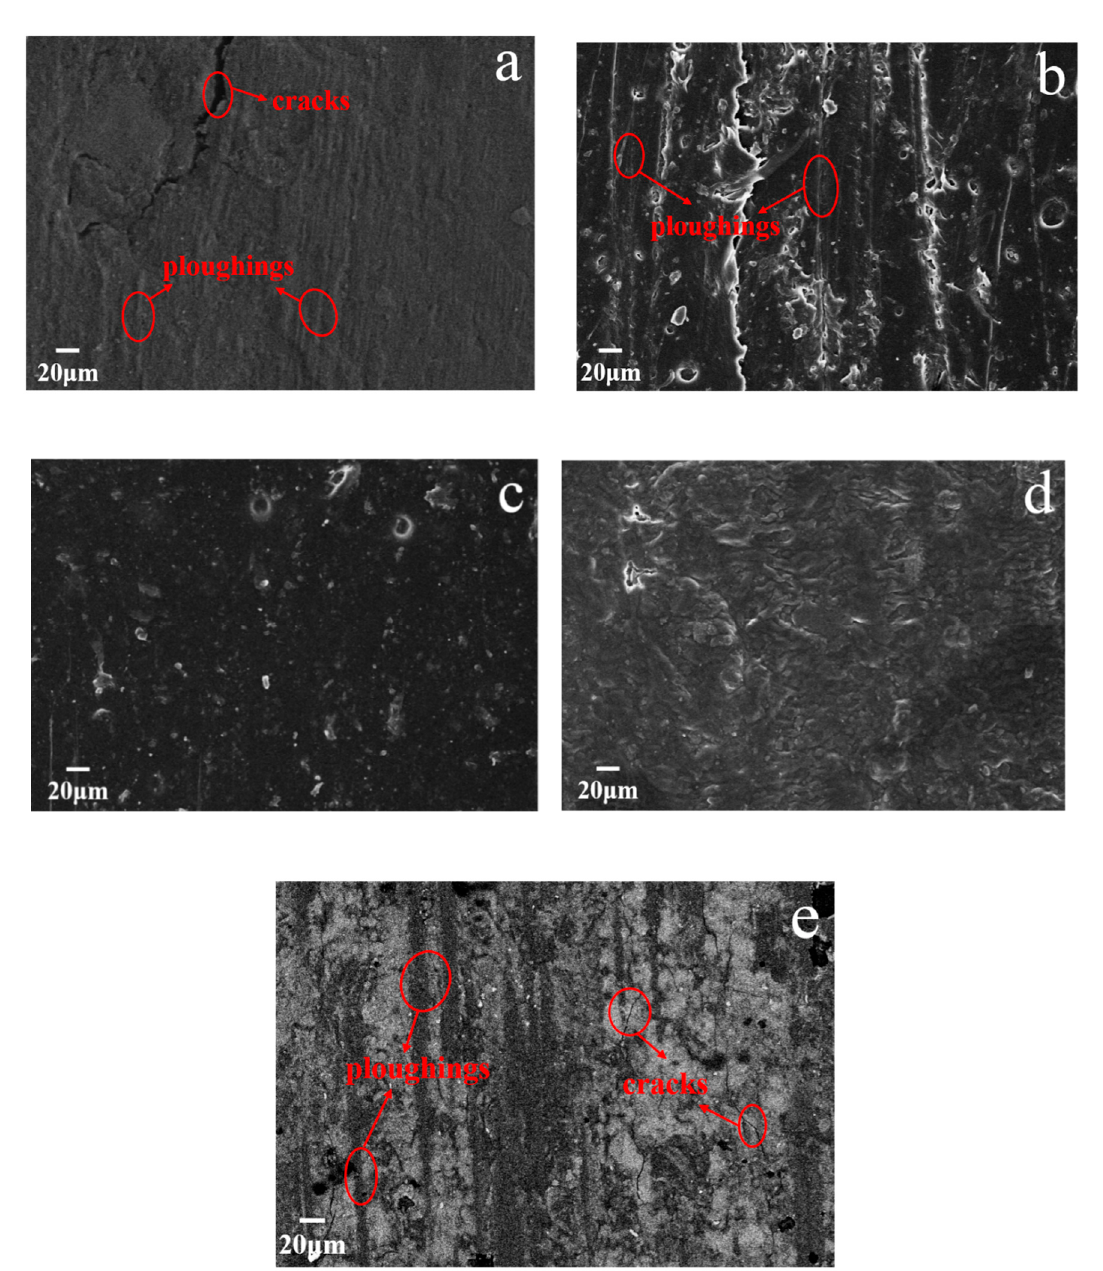
Figure 8. Micrographs of worn surface of MGO-PTFE/WPU composite coating with different mass fractions of MGO, ( a ) 0 wt.%, ( b ) 0.5 wt.%, ( c ) 1.0 wt.%, ( d ) 1.5 wt.%, ( e ) 2.0 wt.%.